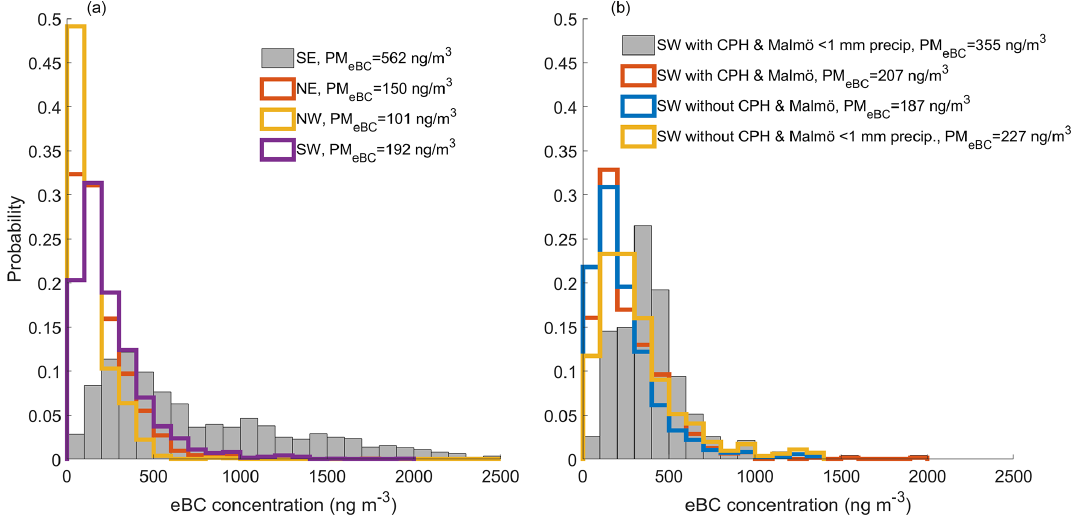
Figure 7. Trajectory analysis of different air mass origins, with corresponding median eBC mass concentrations in the legend. Panel (a) shows histograms with the observed eBC from the Aethalometer at Hyltemossa from the year 2018 for air masses originating from the southeast, northeast, northwest and southwest as defined in Fig. S4. Panel (b) shows the eBC histogram from all SW air masses with or without influence from the Copenhagen (CPH) and Malmö